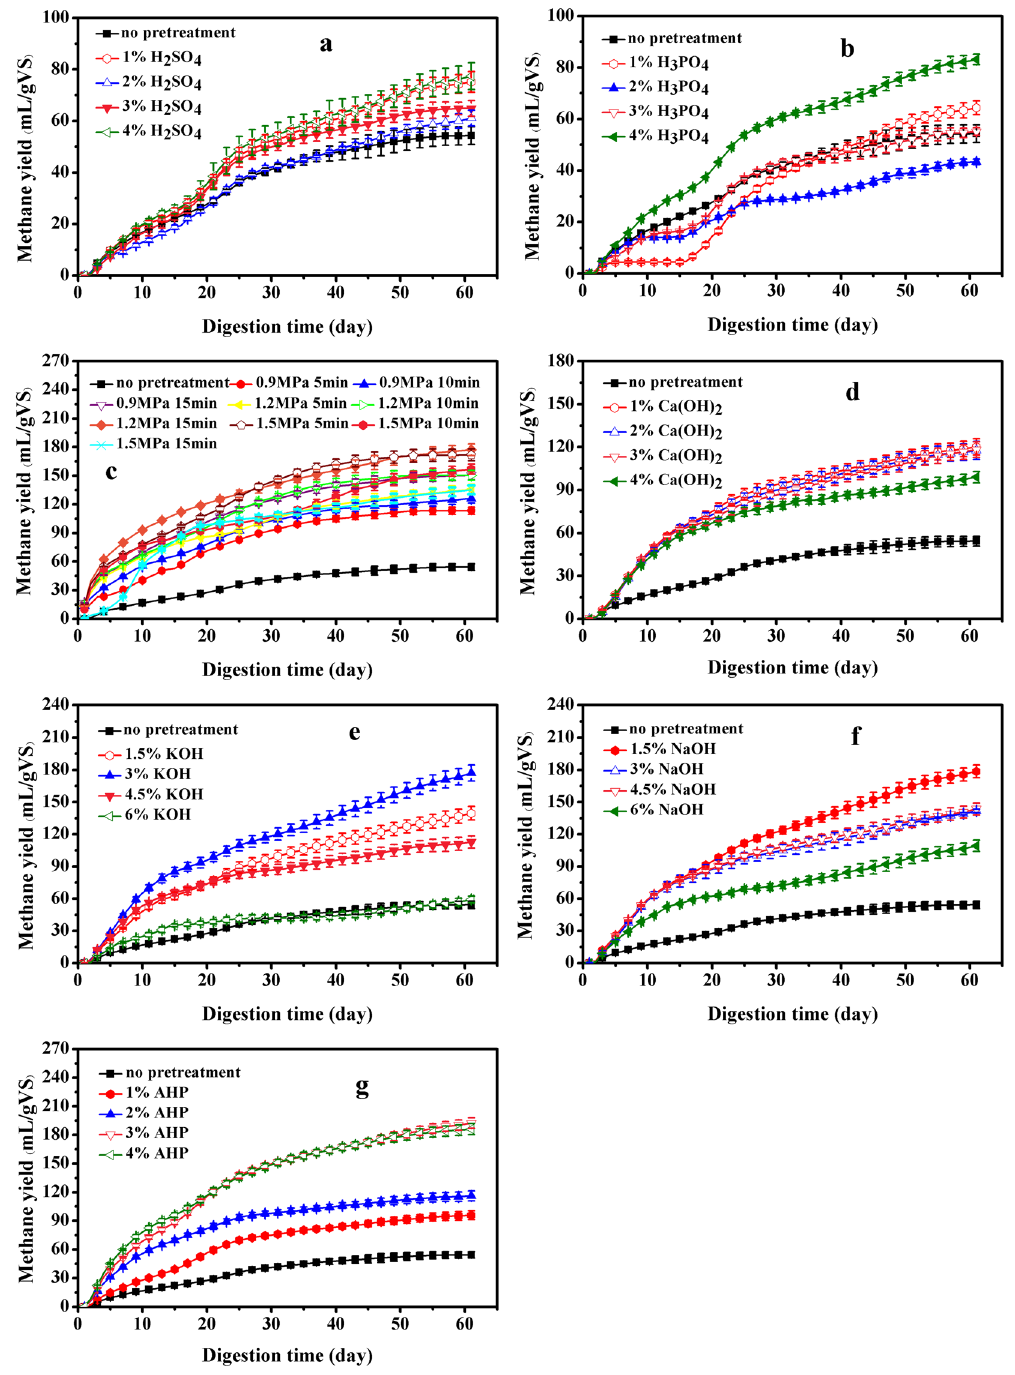
Figure 1. Methane yield of CS, ( a ) H 2 SO 4 -treated CS; ( b ) H 3 PO 4 -treated CS; ( c ) SE-treated CS; ( d ) Ca(OH) 2 - treated CS; ( e ) KOH-treated CS; ( f ) NaOH-treated CS; ( g ) AHP-treated